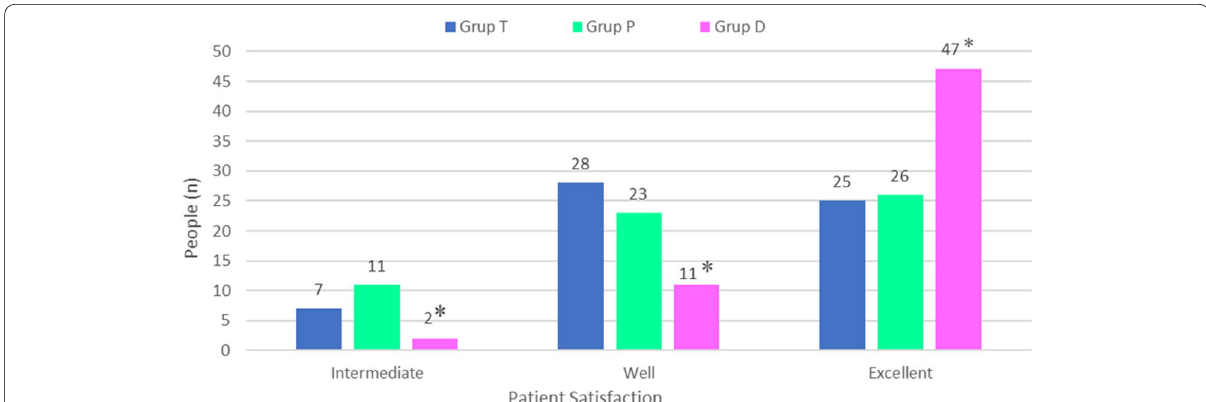
Fig. 6 Graphical presentation of patient satisfaction. * p <0,05 refers to between groups comparisons. T, tramadol group; P, paracetamol group; D, dexketoprofen trometamol